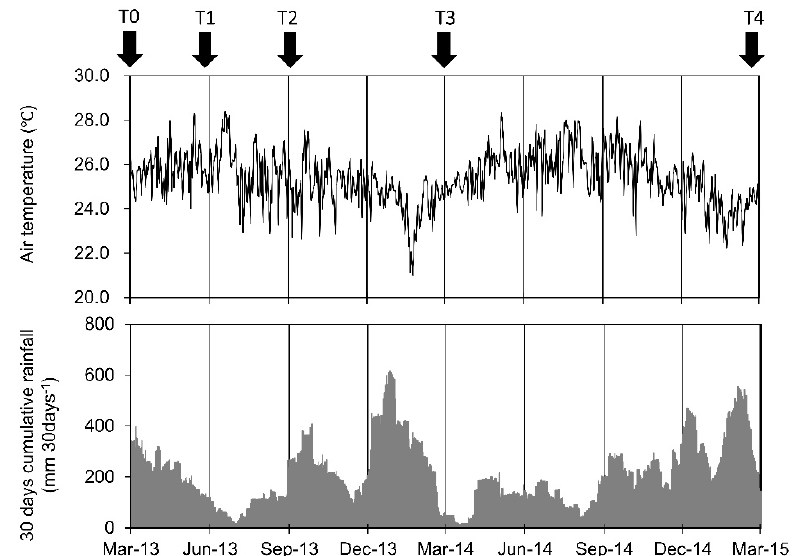
Figure 1. Air temperature and 30-day cumulative rainfall with the timing of core sampling during the study period.